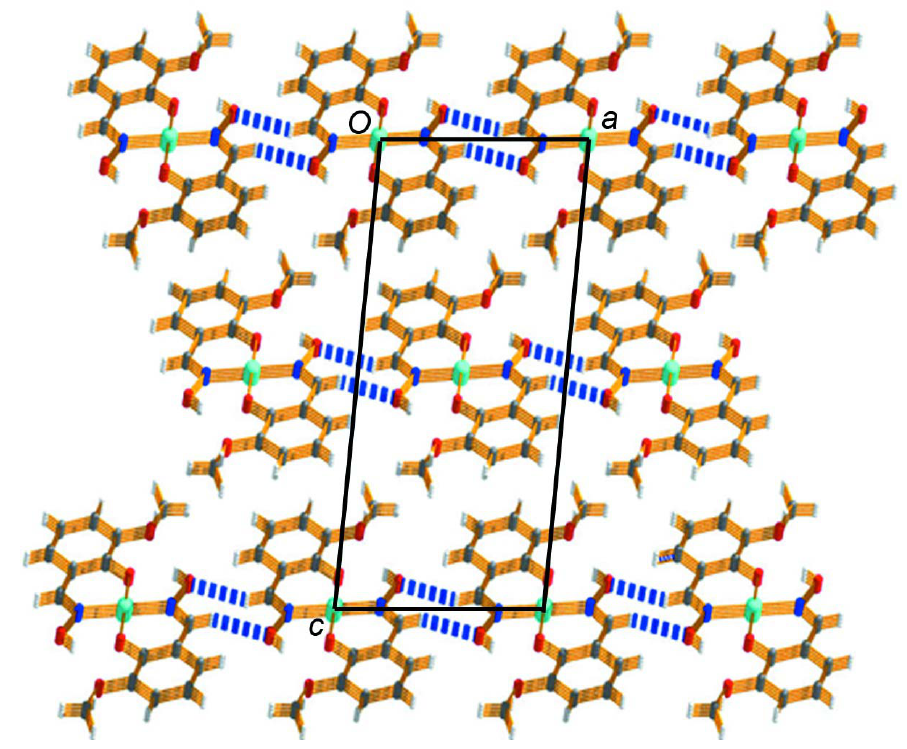
Figure 1 Molecular structure of the title compound, showing 30% probability displacement ellipsoids for non-H atoms. Dashed lines denote O—H···O hydrogen bonds. Symmetry code (A): - x , 1 - y , - z